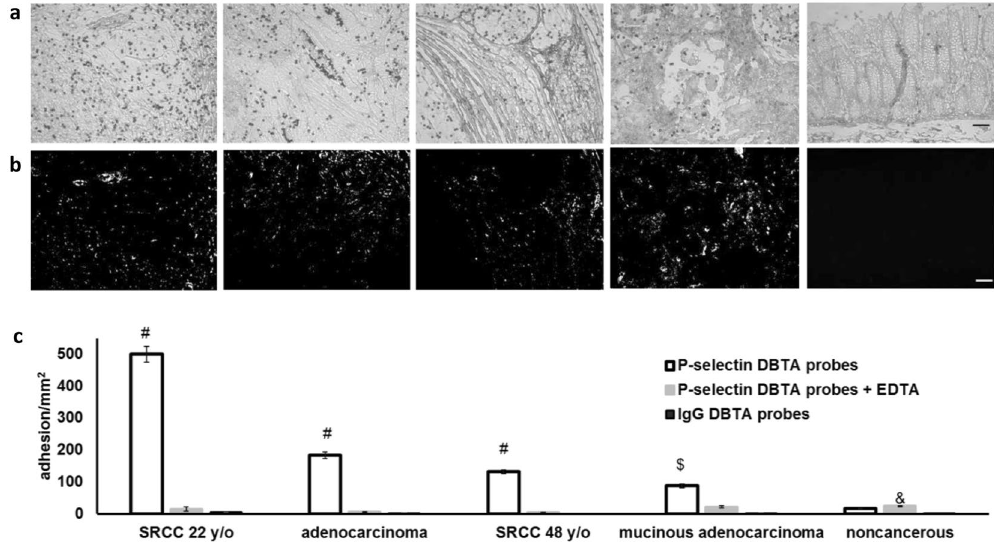
Figure 2. DBTA signal is specific, quantifiable, and discernible from SBTA. ( a ) P-selectin DBTA probes adhesion at 0.50 dyne/cm 2 to colon tissue (from left to right: SRCC T4N1M0 22 y/o, adenocarcinoma T4N0M0, SRCC T4N1M0 48 y/o, mucinous adenocarcinoma T4N2M0, noncancerous colon tissue). DBTA probes appear as black circles. ( b ) P-selectin SBTA conducted on serial sections of the tissues examined in ( a ) with DBTA revealed detection of ligands that are not in complete agreement with the purported functional ligands detected via DBTA ( a ). Order of tissues is the same as ( a ). ( c ) P-selectin DBTA probe adhesion to colon